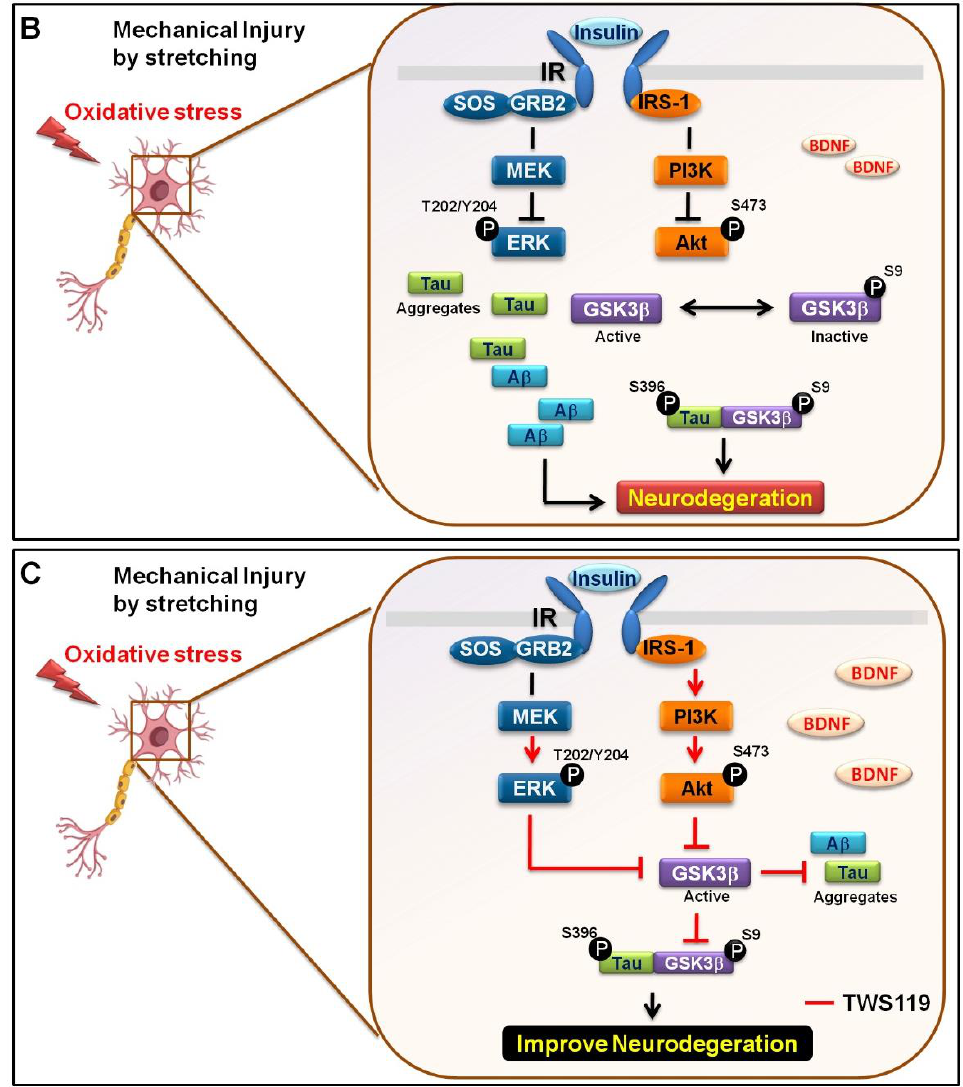
Figure 6. A schematic model suggesting the mechanistic details of the regulation of neurodegener- ative diseases by GSK-3β. ( A ) Under normal conditions, the activated PI3K/Akt ERKs signaling pathway leads to the inactivation of GSK-3β, which suppresses the downstream phosphorylation of Tau and Aβ that results in positive regulation of cognitive signaling, such as BDNF and insulin. dative stress, and increases MMP. Upregulation of GSK-3β activity negatively regulates BDNF and insulin signaling and promotes phosphorylation events critical to the development of Aβ and Tau aggregation. ( C ) Tws119, an inhibitor of GSK-3β, improves pathological conditions by positively regulating BDNF and insulin signaling. Moreover, it reduces phosphorylation events critical to the development of Aβ and Tau aggregation. BDNF, brain-derived neurotrophic factor; MMP, mitochondrial membrane potential; and GSK-3, glycogen synthase kinase